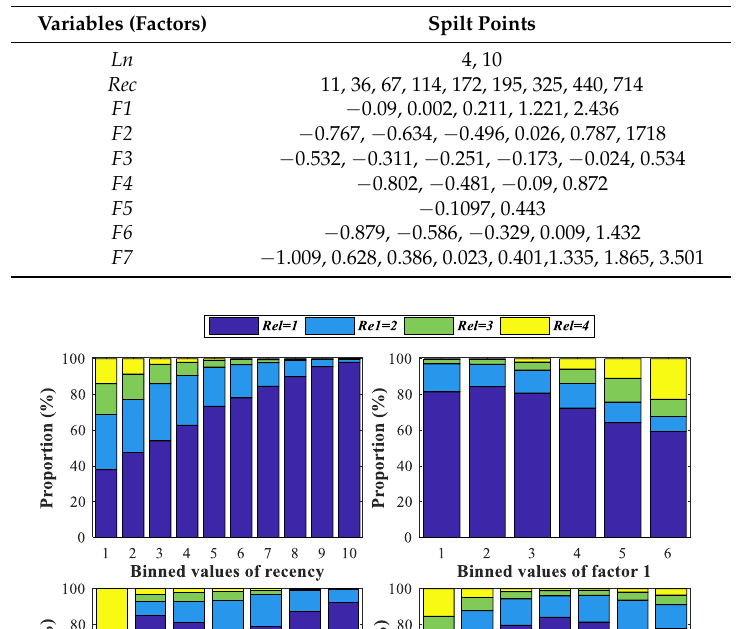
Table 4. Discretized results of variables.